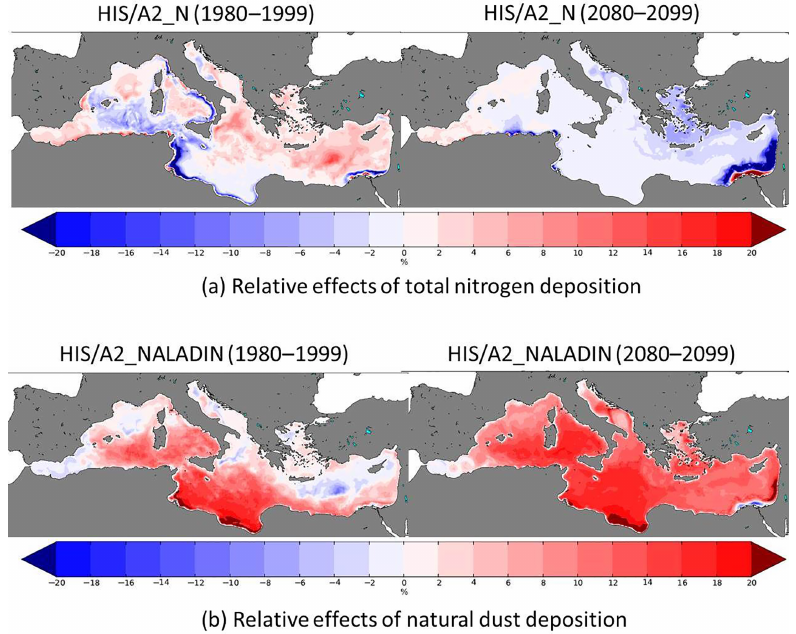
Figure 17. Present (1980–1999) and future (2080–2099) relative effects of total nitrogen (a) and natural dust (b) deposition on surface (0–10m) total primary